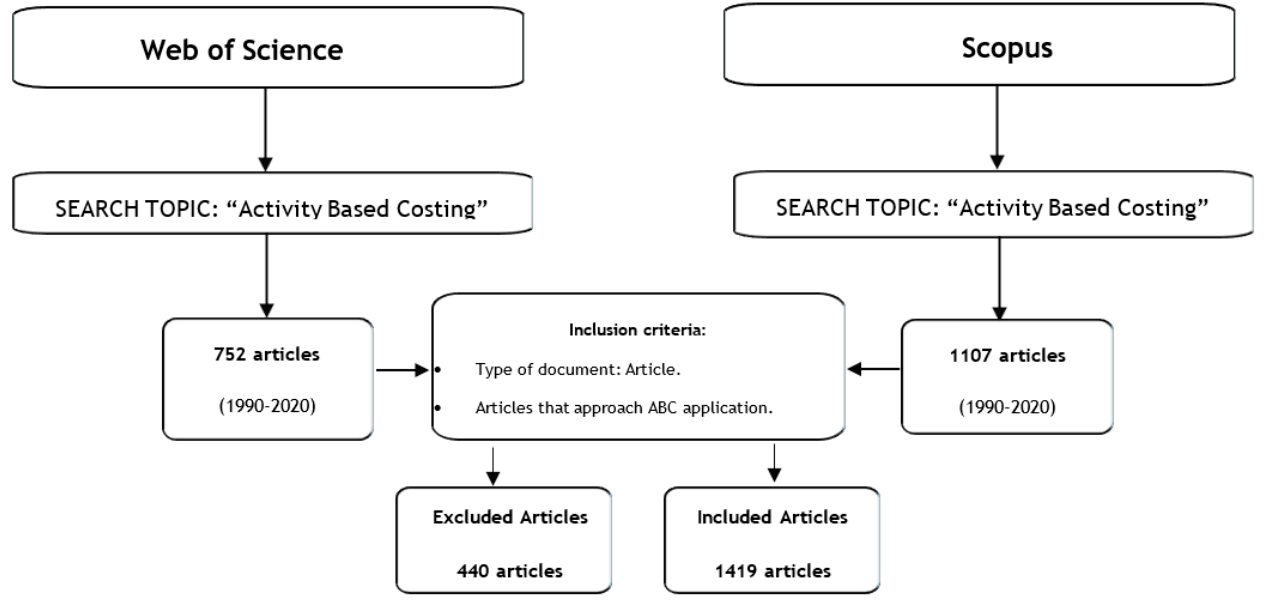
Figure 1. Search Figure 1. Search results.